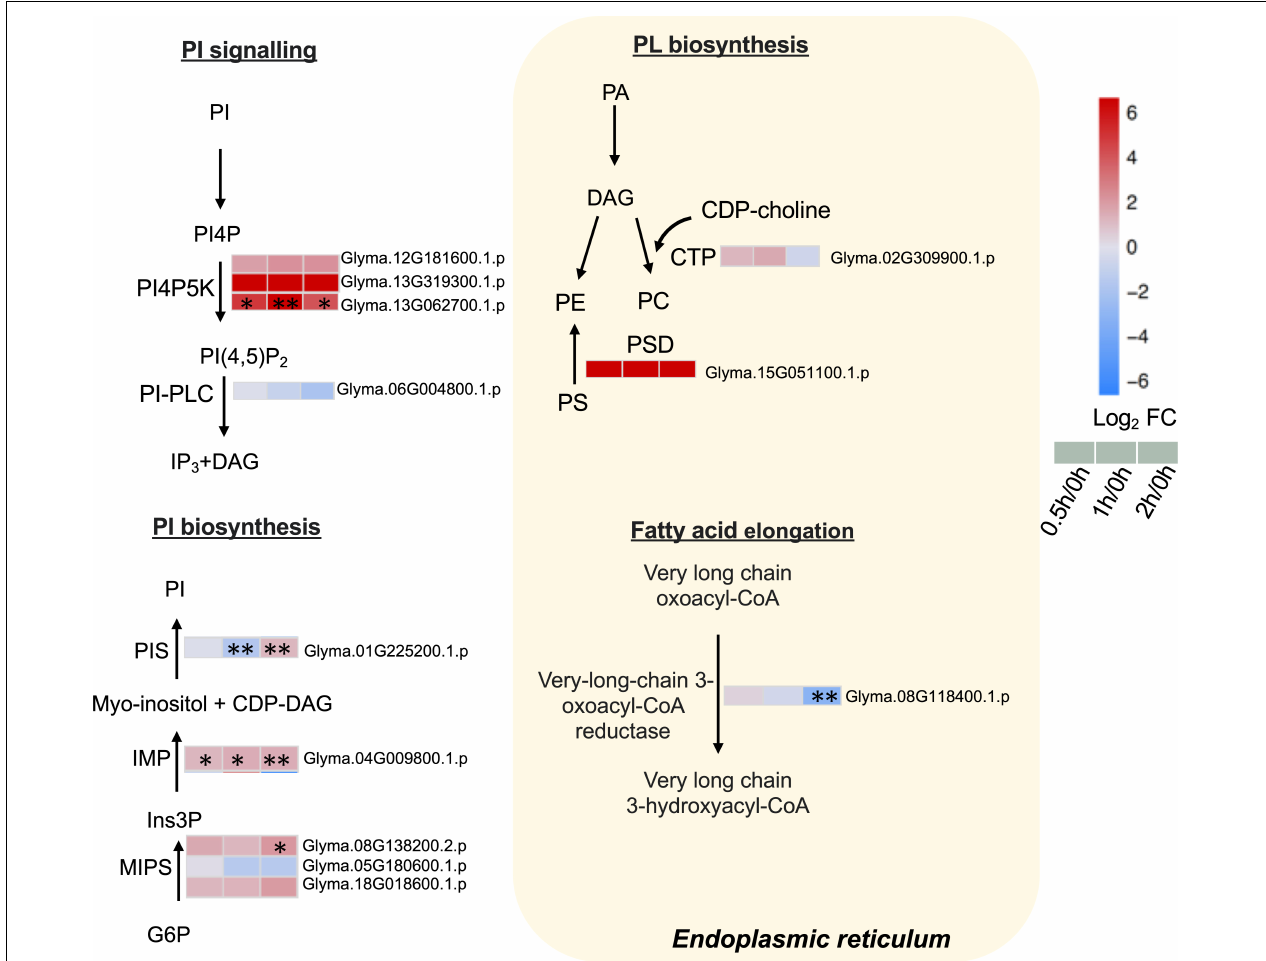
FIGURE 6 | Proteins with differential abundance involved in phospholipid metabolic pathways during salt stress in leaves of soybean ( Glycine max [L.] Merr.) accession C08. Each significant differentially expressed protein is presented as heatmaps with shades of red or blue according to the scale bar. Scale bar indicates log 2 -fold changes of protein abundance (stress vs. control) with an adjusted p -value ≤ 0.05. ∗ , significant difference at p ≤ 0.05; ∗∗ , significant difference at p ≤ 0.01 using ANOVA test. For tandem mass spectrometry, the total leaf protein was extracted from leaves of 14-day-old C08 seedlings grown in 1/2 strength Hoagland solution and treated with or without 0.9% (w/v) NaCl. Differential protein abundances were calculated by label-free quantification of MS peptide signals. CDP-choline, cytidine diphosphate choline; CDP-DAG, cytidine diphosphate diacylglycerol; PA, phosphatidic; CTP, choline-phosphate cytidylyltransferase; DAG, diacylglycerol; G6P, glucose 6-phosphate; Ins3P, myo –inositol–3–phosphate; IMP, inositol monophosphatase; MIPS, myo -inositol-1-phosphate synthase; PA, phosphatidic acid; PC, phosphatidylcholine; PE, phosphatidylethanolamine; PI, phosphatidylinositol; PI(4,5)P 2 , phosphatidylinositol 4, 5-bisphosphate; PI4P, phosphatidylinositol 4-phosphate; PI4PK5, phosphatidylinositol-4-phosphate 5-kinase; PI-PLC, phosphoinositide phospholipase C; PIS, phosphatidylinositol synthase; PS, phosphatidylserine; PS decarboxylase, phosphatidylserine